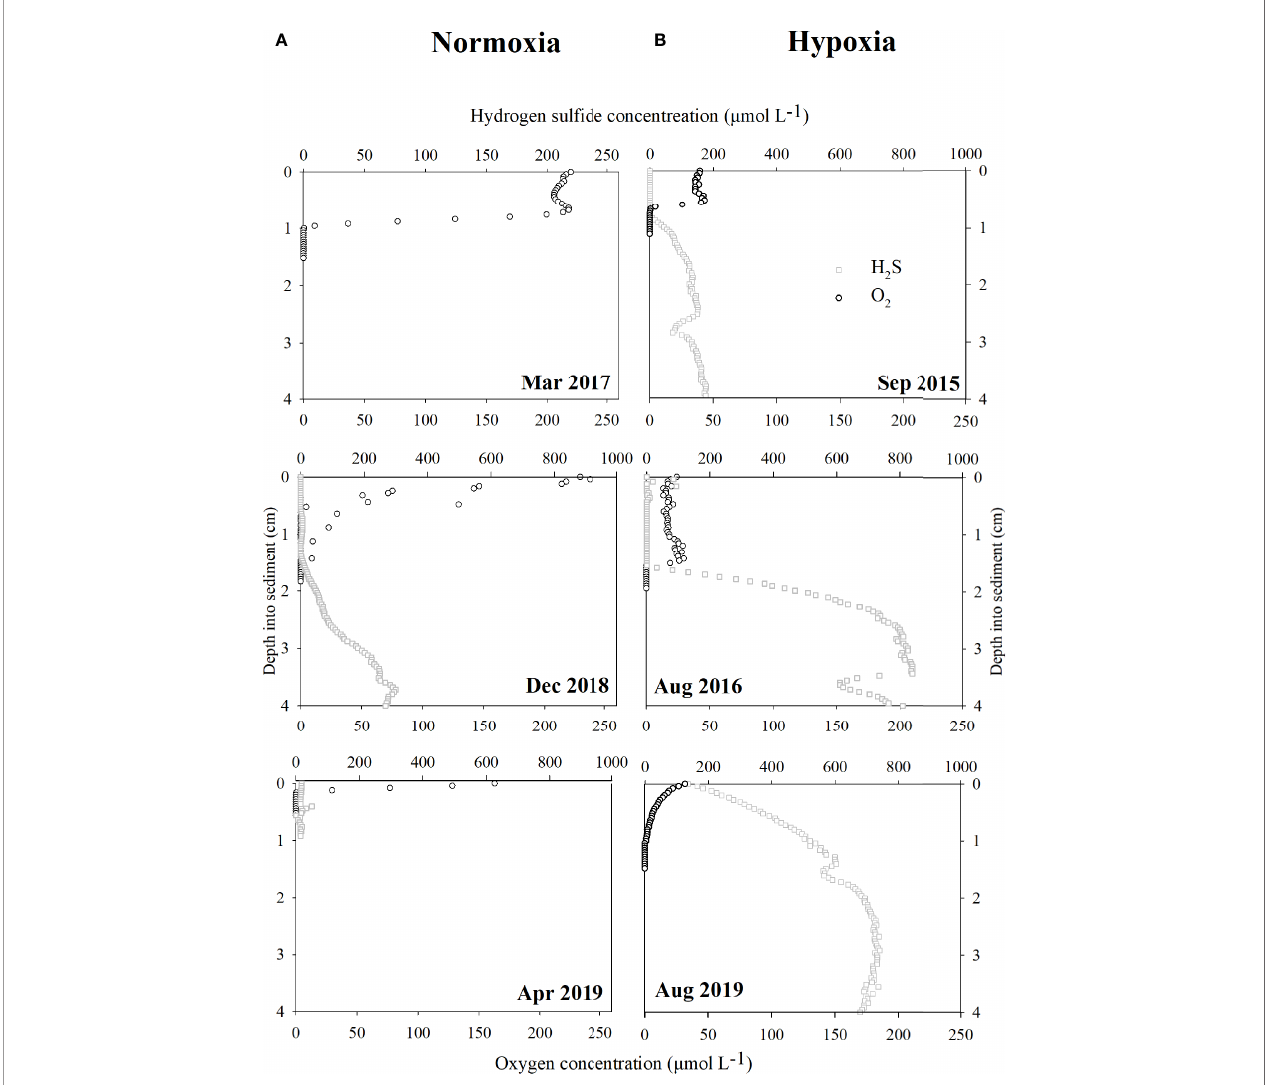
FIGURE 2 | Sediment microelectrode pro fi les of oxygen (O 2 , black circle) and hydrogen sul fi de (H 2 S, gray square) at DD site in Jinhae Bay from Sep 2015 to Nov 2019 during the sampling period. Results are shown for the (A) hypoxia and (B) normoxia periods. Note that O 2 and H 2 S have different axes (except for pro fi les generated in Mar 2017). H 2 S pro fi les in Apr 2019 are only available for 1 cm depth into sediments. The top axis is for H 2 S, and the bottom axis is for O 2 . All pro fi les derived from DD2 site, except for Sep 2015 (DD1